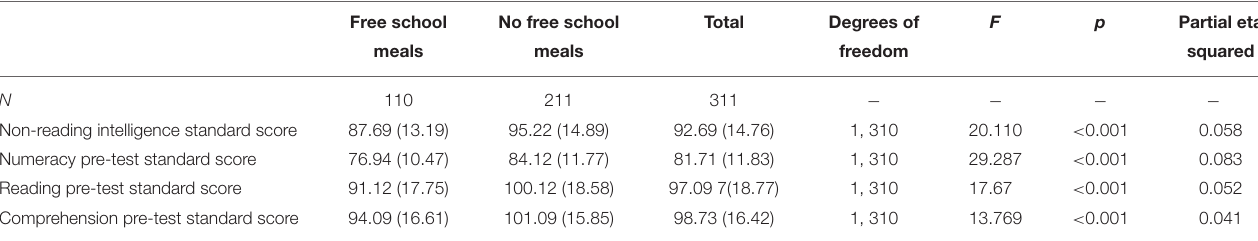
TABLE 7 | Mean starting ages and pre-test standard scores of children with and without free school meals and results of ANOVAs comparing groups.